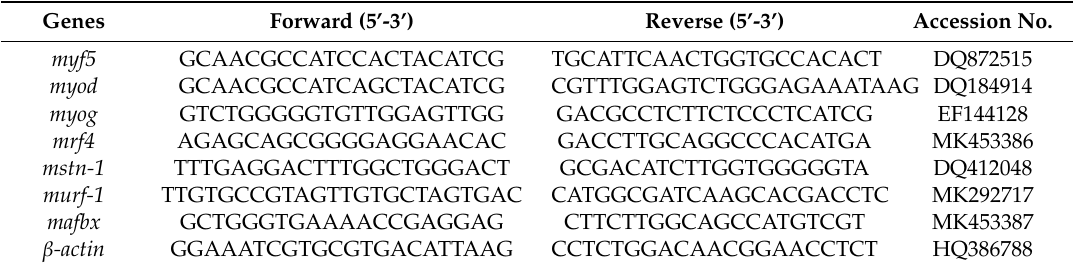
Table 1. List of PCR primer pairs used for the real-time Q-PCR